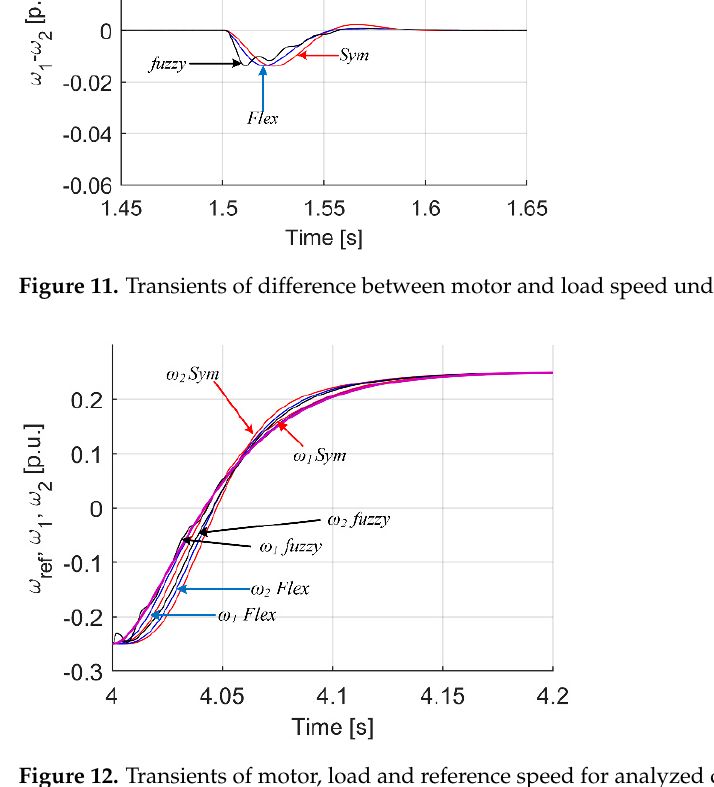
Figure 13. Transients of difference between motor and reference speed for analyzed controller cases. Figure 14. Transients of motor, load and reference speed for analyzed controller cases.